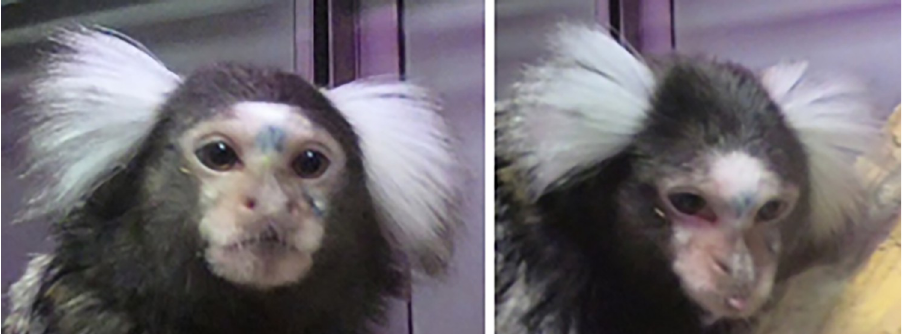
Fig 18. AU118—Lip Pucker. Left: Neutral; Right: AU118 is present during AD19—Tongue Show.